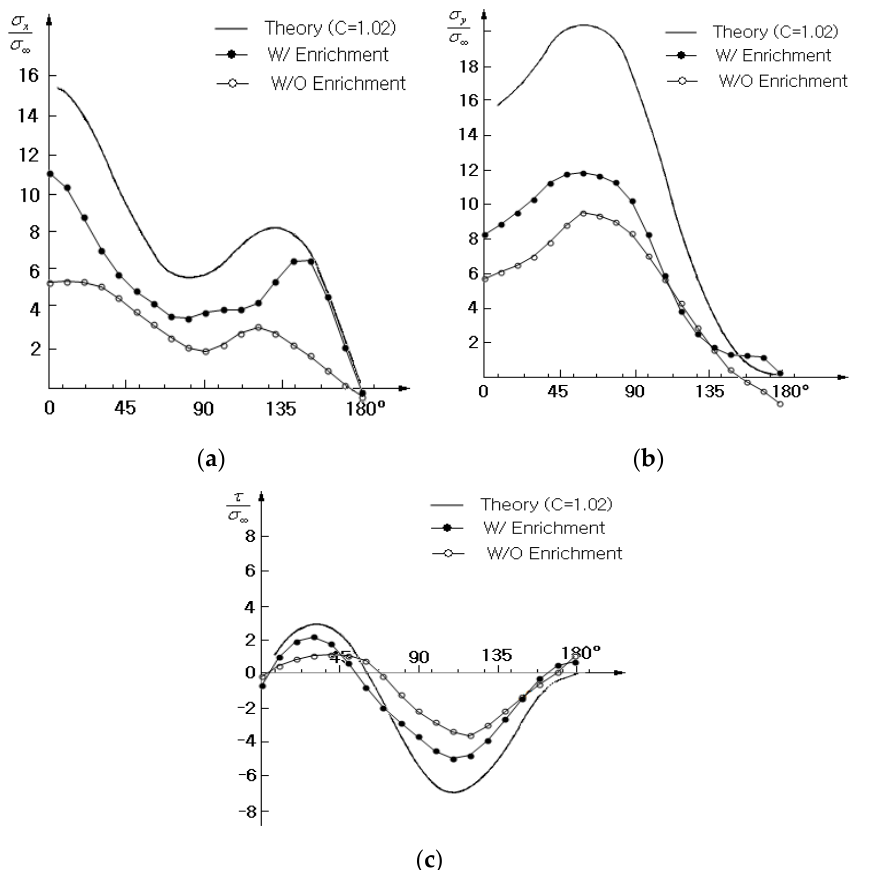
( ) σ 01390 .a/r = : ( a ) , ( b ) xx